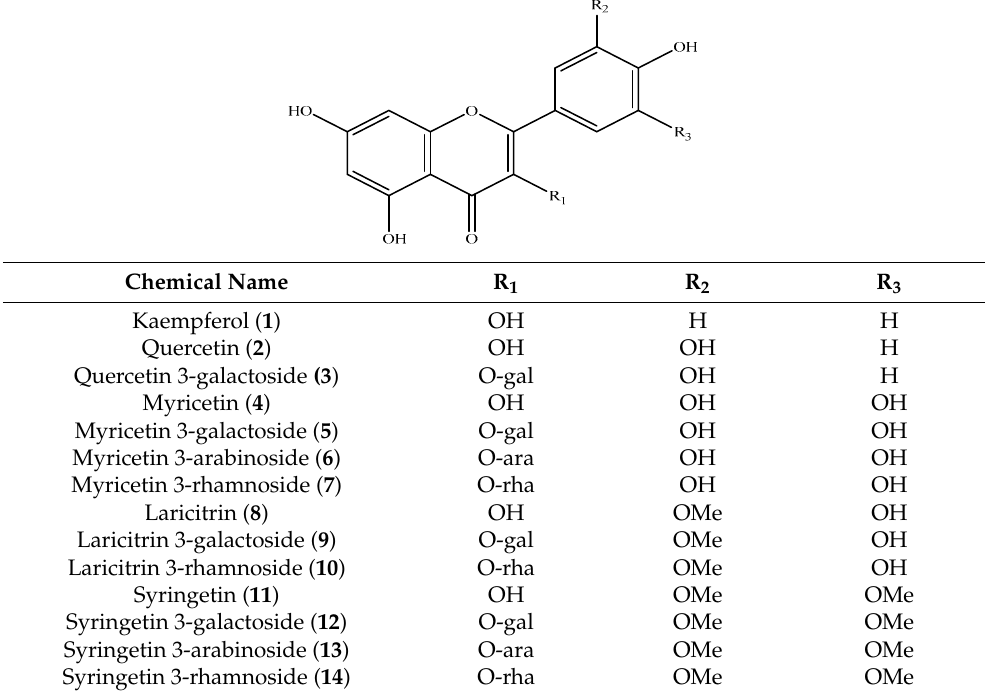
Syringetin 3-rhamnoside ( 14 ) O-rha OMe